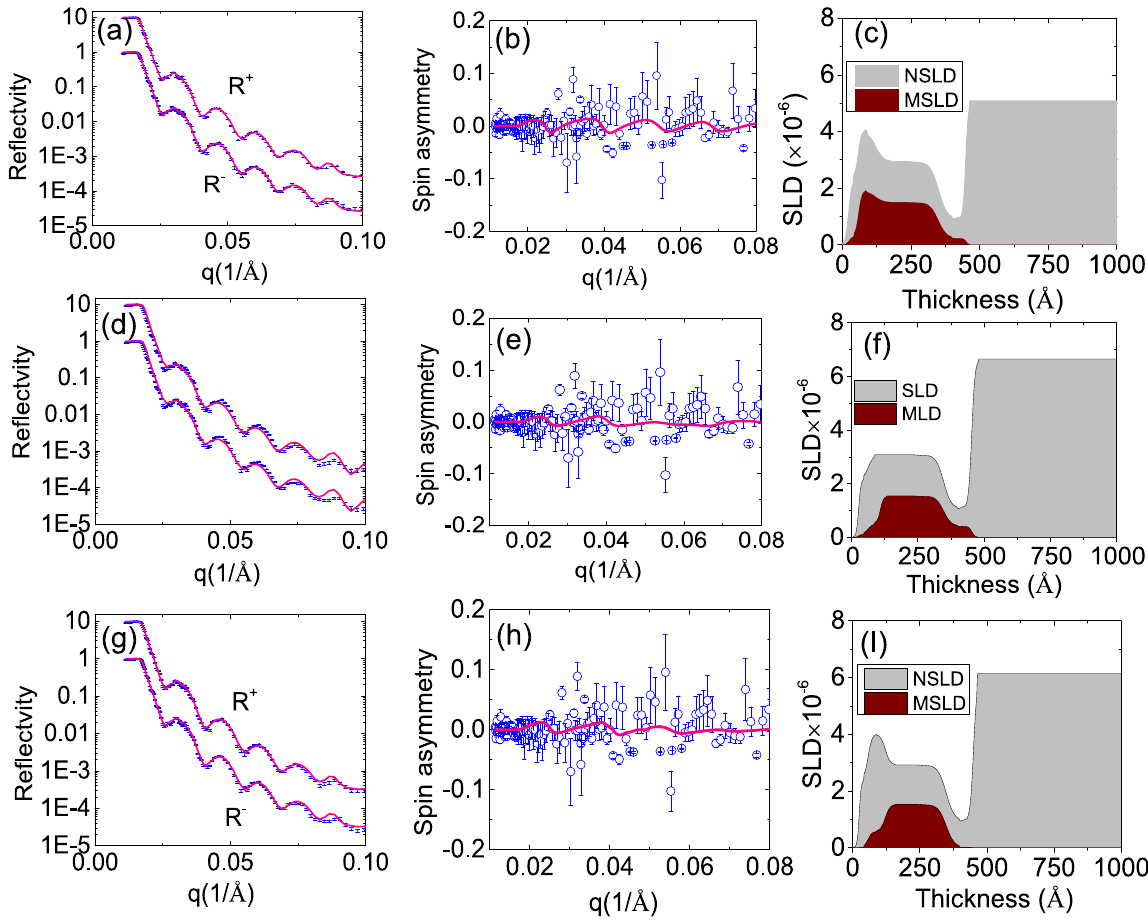
Figure 5. PNR data of Cu-ZnO deposited under an oxygen partial pressure of 10 − 3 torr with different types of fittings. The results of the best fit are presented in the top panel for R + and R- reflectiviity, ( a ). Spin asymmetry ( b ). NSLD/MSLD profiles with nonuniform fittings ( c ). The experimental data are shown with blue circles with error bars and the fitting curves are shown with the red solid lines. In order to see clearly, the Y axis of MSLD has been multiplied by 50 times. The middle and the bottom panels confirm that the fit with a uniform NSLD/ MSLD ( d ),( e ),( f ) and the nonuniform fittings of NSLD and unform MSLD ( g ),( h ),( i ) doe not provide a good agreement with the experimental data (solid lines deviate from the data from 0.07 < q < 0.1 in ( d ) and ( g )).